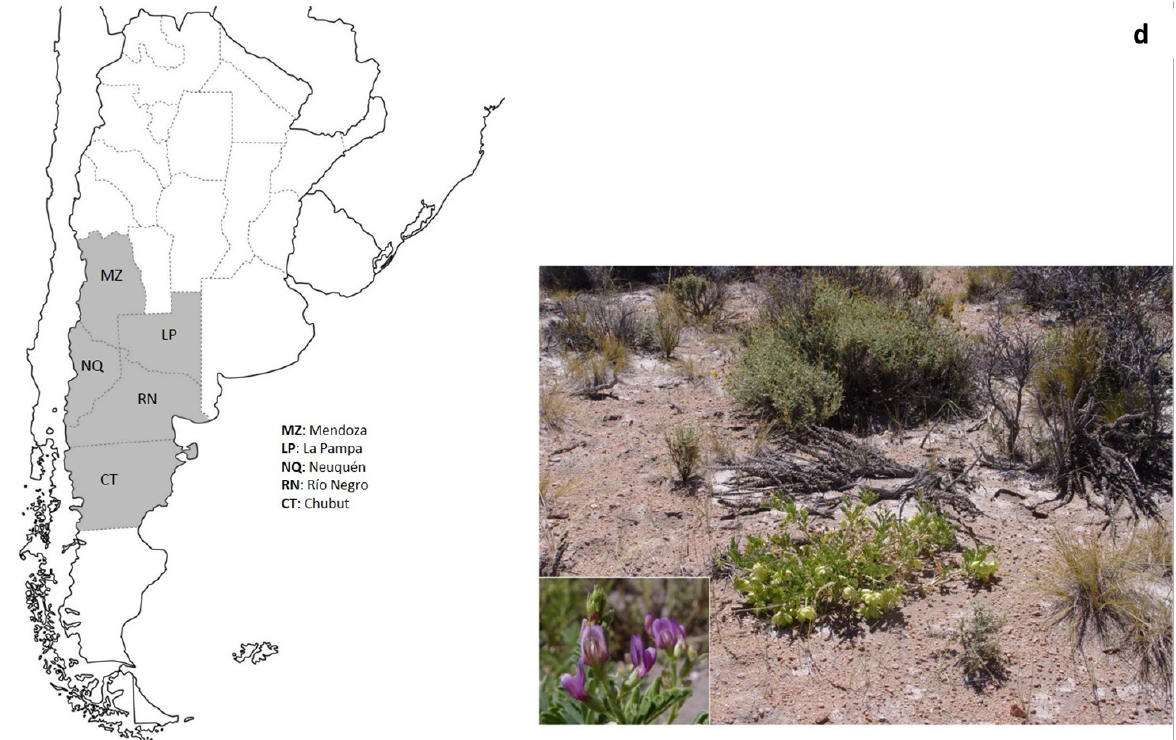
Figure 2d. Distribution of Astragalus pehuenches in